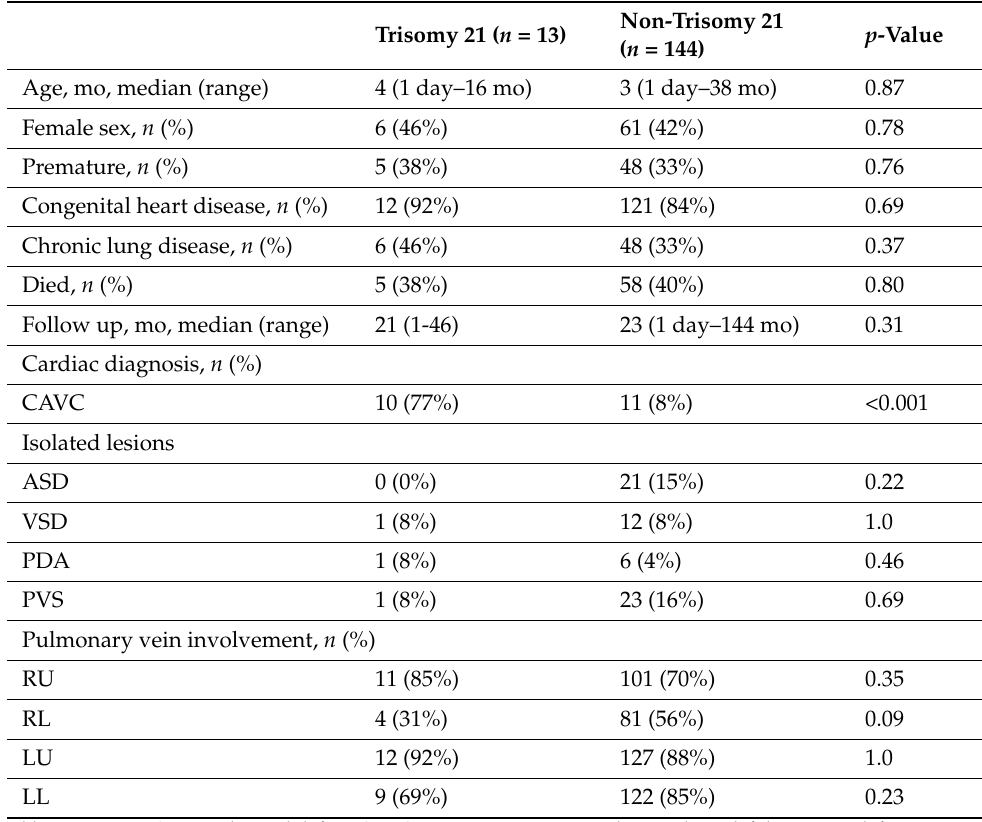
Table 6. Comparison of PVS patients with and without Trisomy